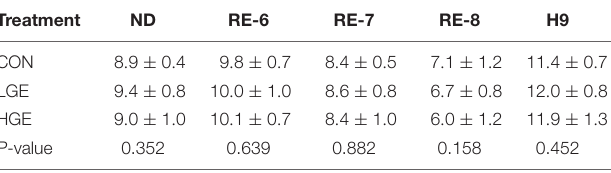
TABLE 6 | Effect of dietary GEN on serum antibody titers in hens.